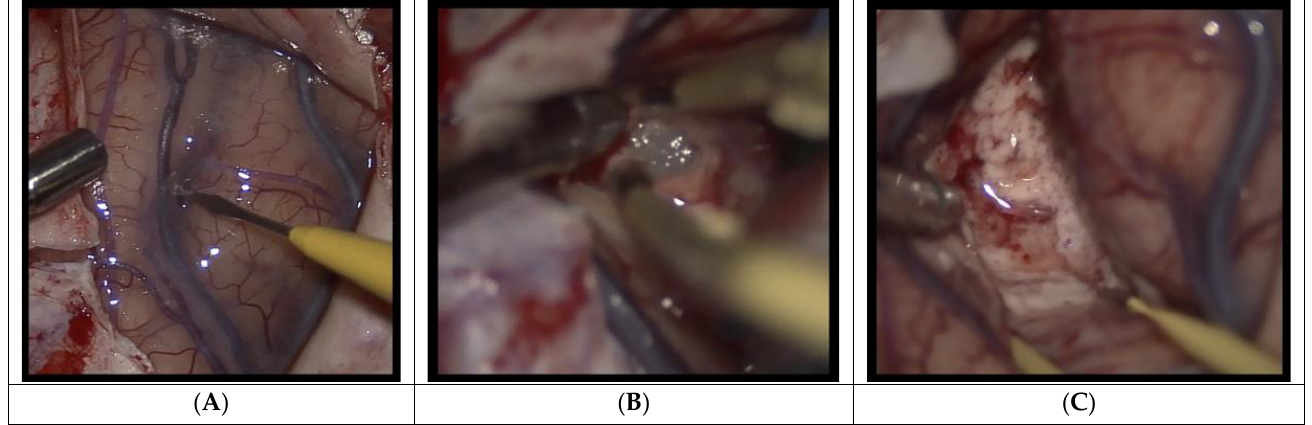
Figure 5. Demonstration of some steps of the trans-sulcal approach after opening the dura. ( A ): Opening of the precentral sulcus arachnoid. ( B ): Partial resection of the lesion after corticectomy in the floor of the sulcus. ( C ): Complete resection of the lesion with wide dissection of the sulcus clearly visible.